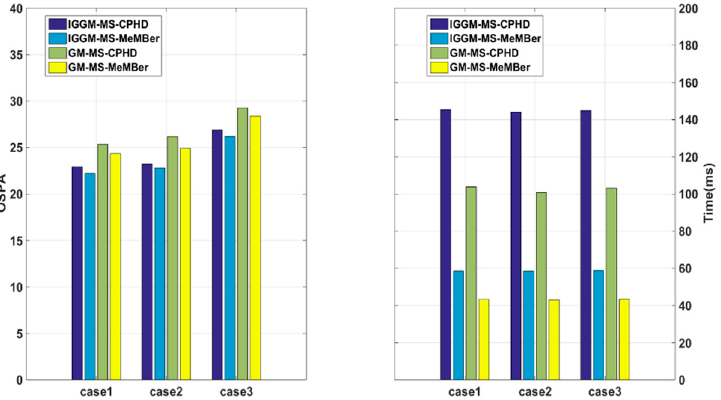
Figure 8. Performance under different sensor distributions.